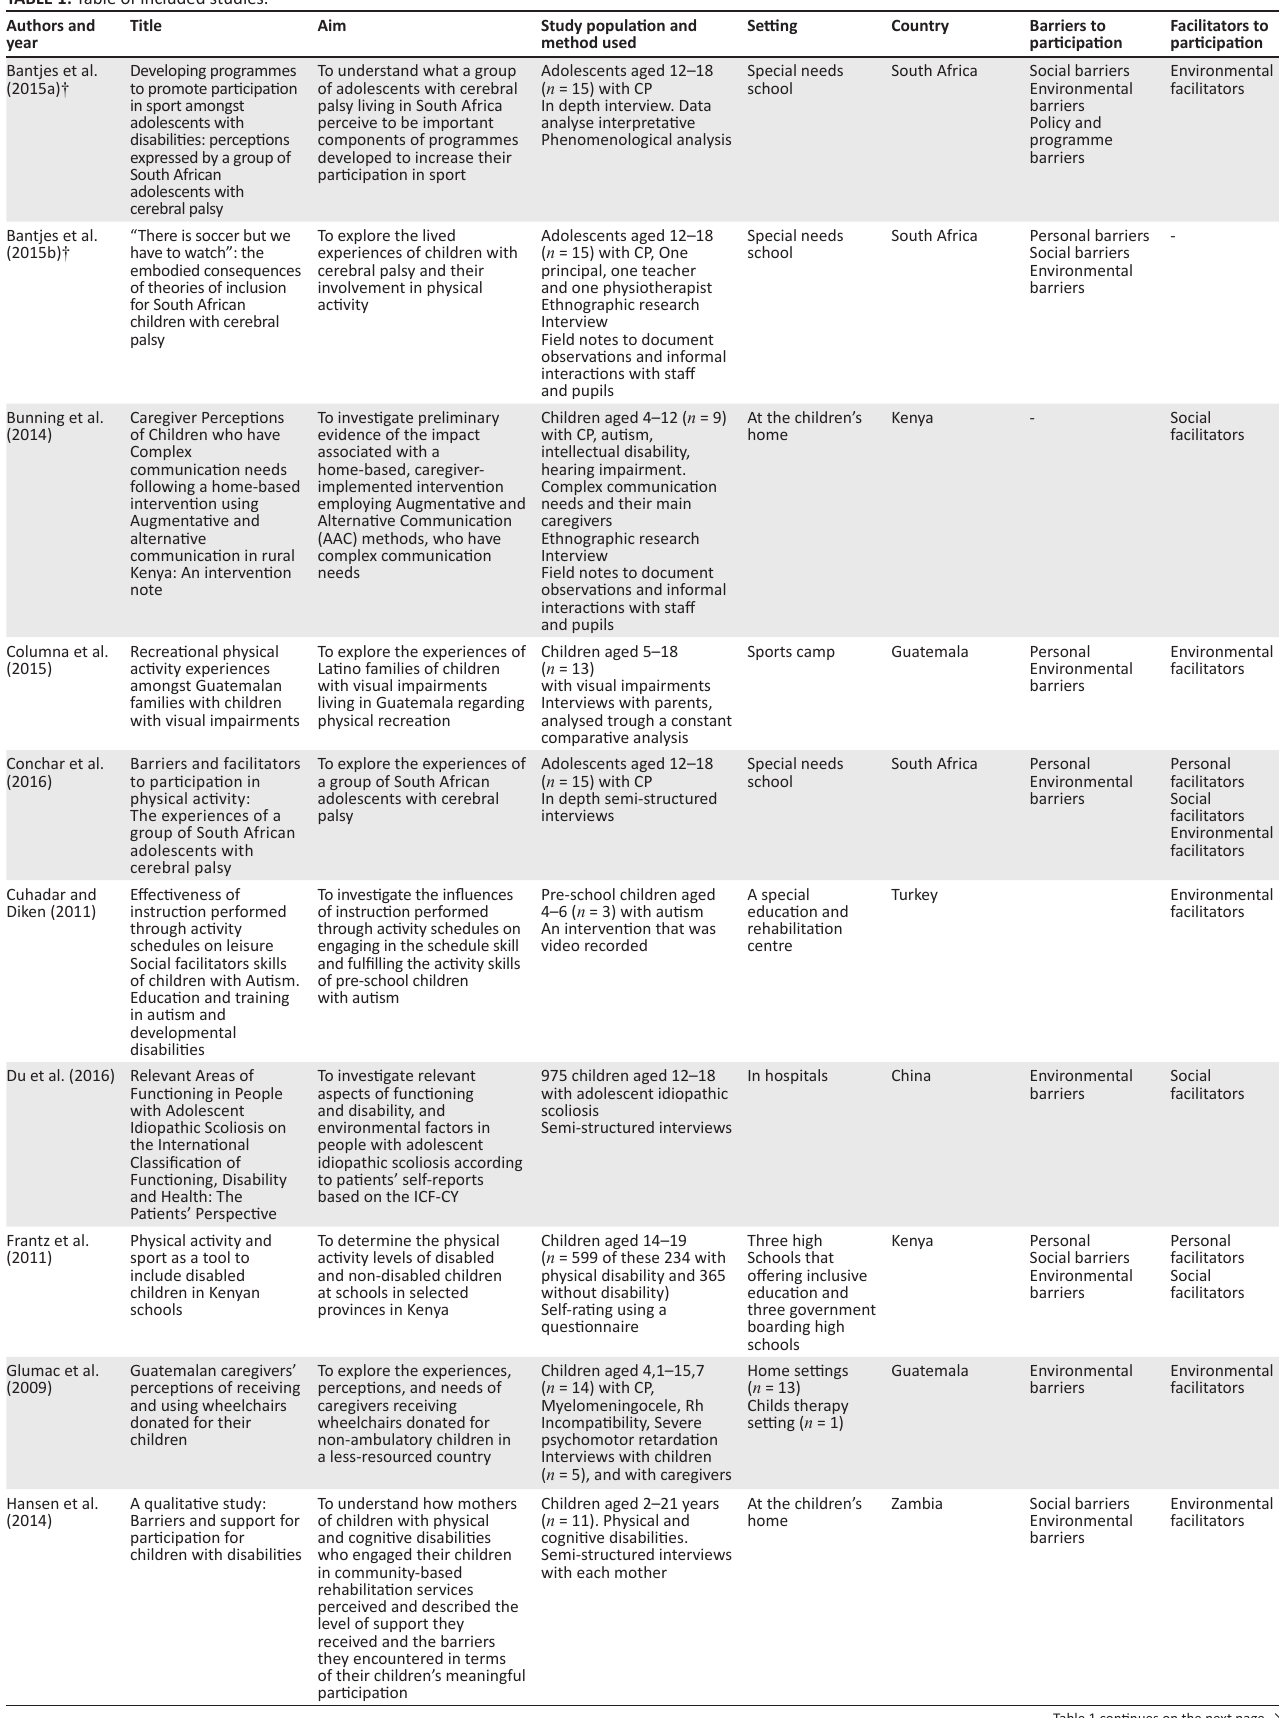
TABLE 1: Table of included